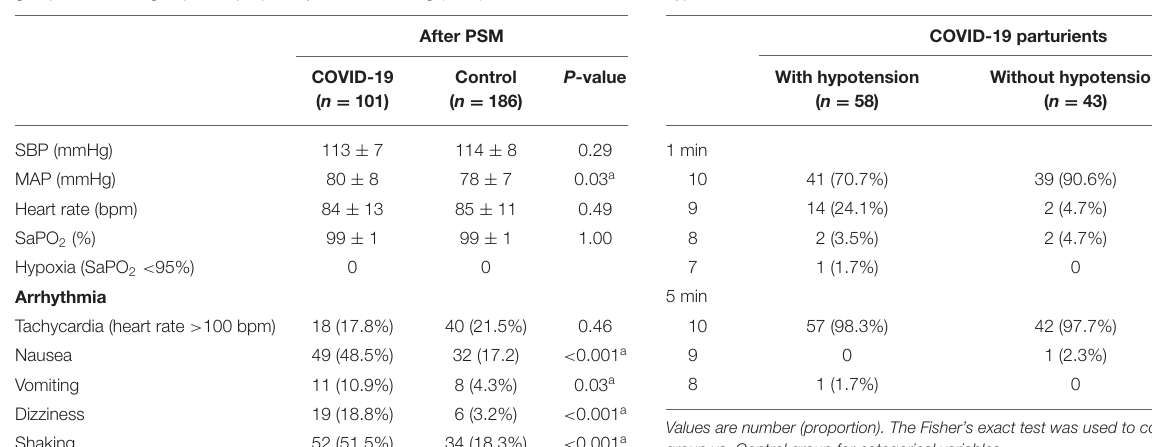
TABLE 4 | Intraoperative maternal vital signs and adverse reactions in COVID-19 group vs. Control group after propensity score matching (PSM).